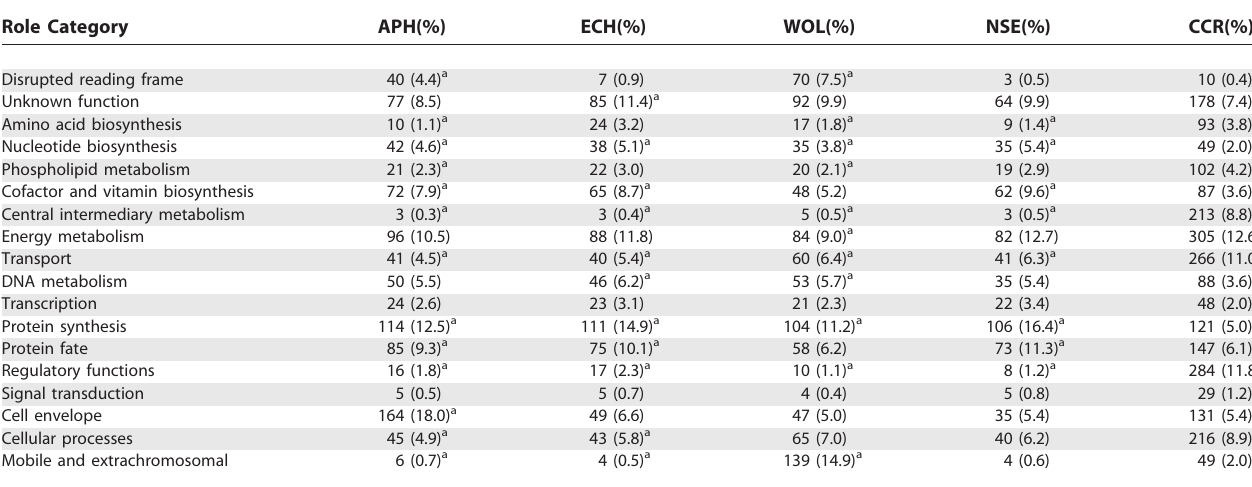
Table 3. Comparison of Role Category Breakdown Role